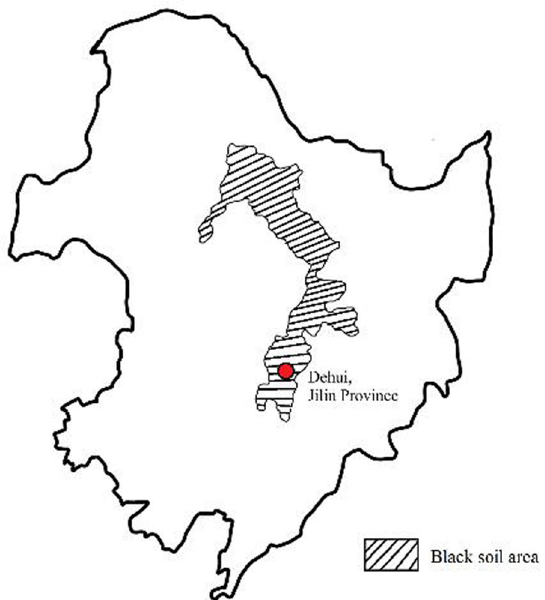
Fig 1. Sixteen hectares of black soil cornfield fixed monitoring plot location. The map shows the administrative divisions of China. The solid line in the picture is northeast of China. The red dot is the location of the experiment. The shaded area is the black soil distribution area. This map was drawn by our laboratory based on the long-term experimental investigation of the approximate distribution of the black soil area in the middle of the Northeast